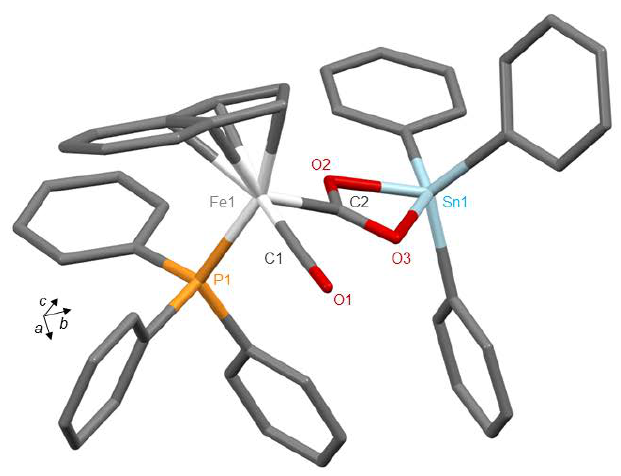
Figure 21. Molecular structure of 18 , adapted from [75] (MERCURY view). Hydrogen atoms are omitted for clarity (Sn light blue, O red, P orange, Fe white, C grey).